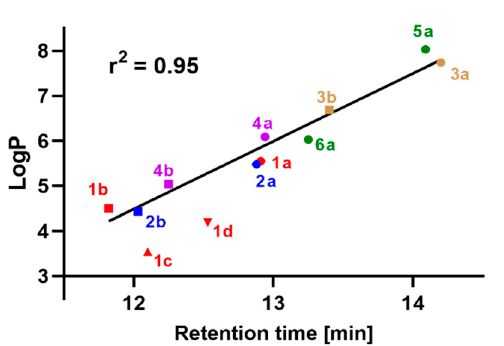
Figure 3. Correlation of RP-HPLC retention times of the studied compounds with theoretical LogP values. Compounds 1c and 1d excluded from the correlation. Points are colored so that analogues with the same peptide sequence have the same color.